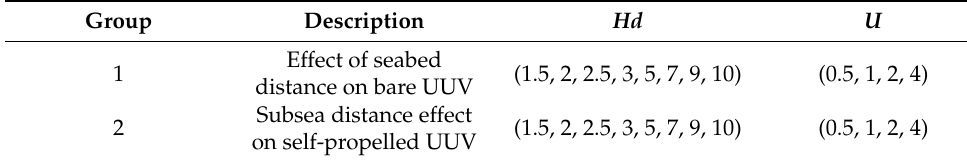
Table 3. Simulation case classification.